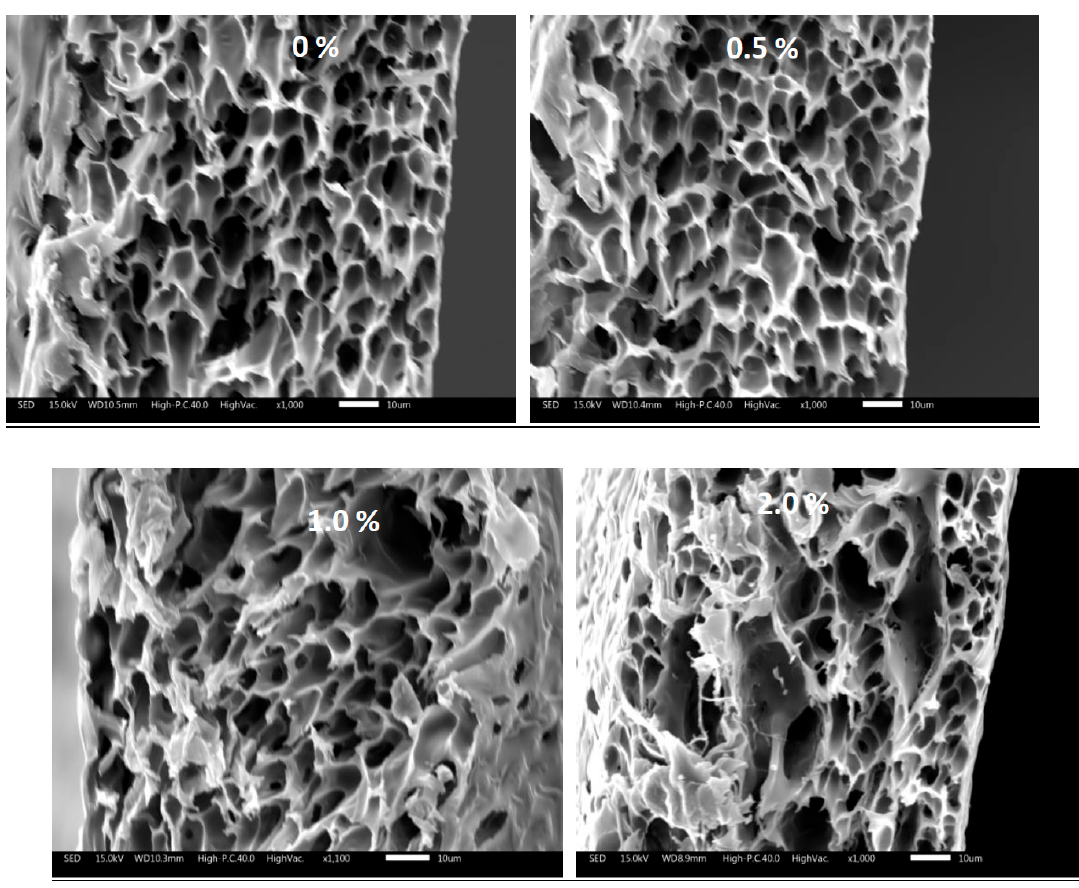
Table 2. Diameter of pores at the surface of PSF/RSNF films.